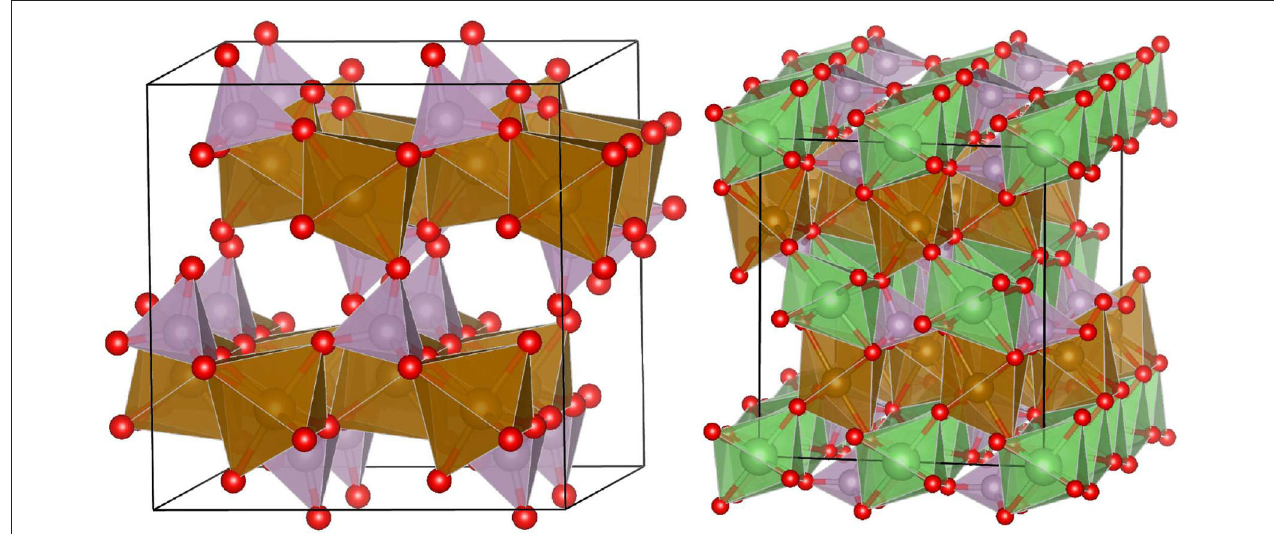
FIGURE 1 | Structures of FePO 4 (left) and LiFePO 4 (right)